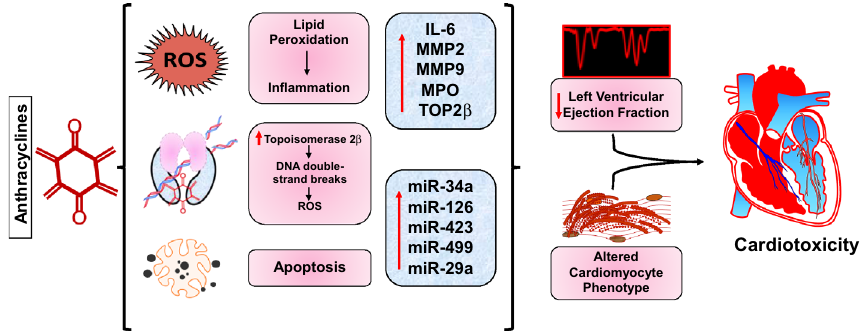
Figure 7. Schematic representation of anthracyclines induced cardiotoxicity. The treatment of breast cancer patients with an anthracycline regimen results in excessive ROS production with subsequent oxidant stress and inflammation in the cardiomyocyte. Anthracycline treatment also results in double strand DNA damage as well as cellular apoptosis which further contributes to the cardiotoxicity. The upregulation of biomarkers and circulating miRNAs associated with these pathological mechanisms operant in response to anthracycline treatment contributes to a decline in LVEF and altered cardiomyocytes, hence predicting early cardiotoxicity